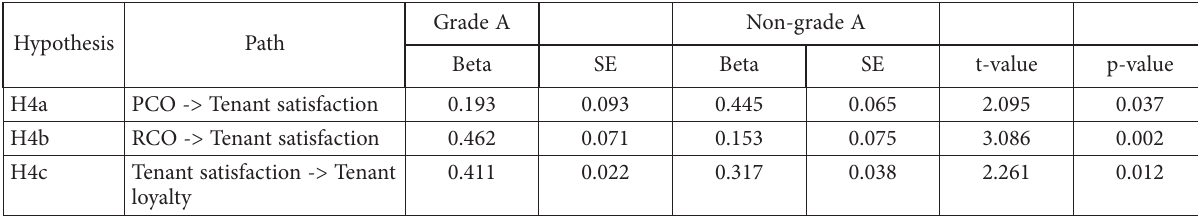
Table 8. Path differences by office building